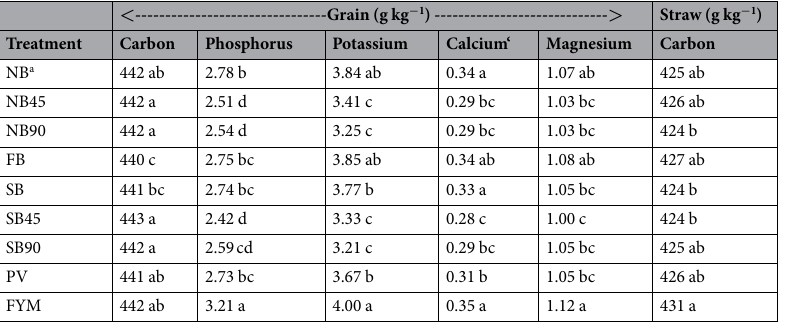
Table 1. Mean concentration of significantly affected nutrients in the wheat grain after 84 years in the crop residue long-term experiment (CR-LTE), Pendleton, OR. Means sharing the same letter within the columns are not significantly different at 0.05 probability level. a NB = No burn, SB = spring burn, FB = fall burn, FYM = farmyard manure, and PV = pea vine. 0, 45, 90 accompanied by NB, SB, and FB represents rates of